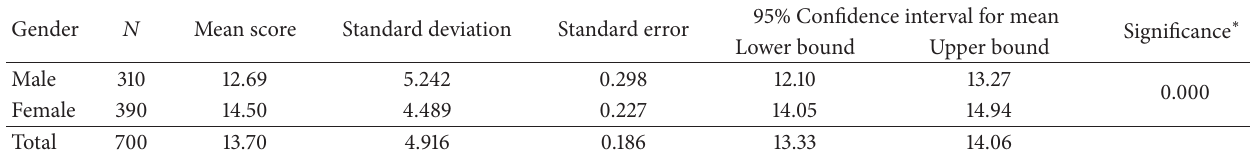
Table 1: The distribution of the study sample by gender and the mean score of the Modified Corah Dental Anxiety scale.